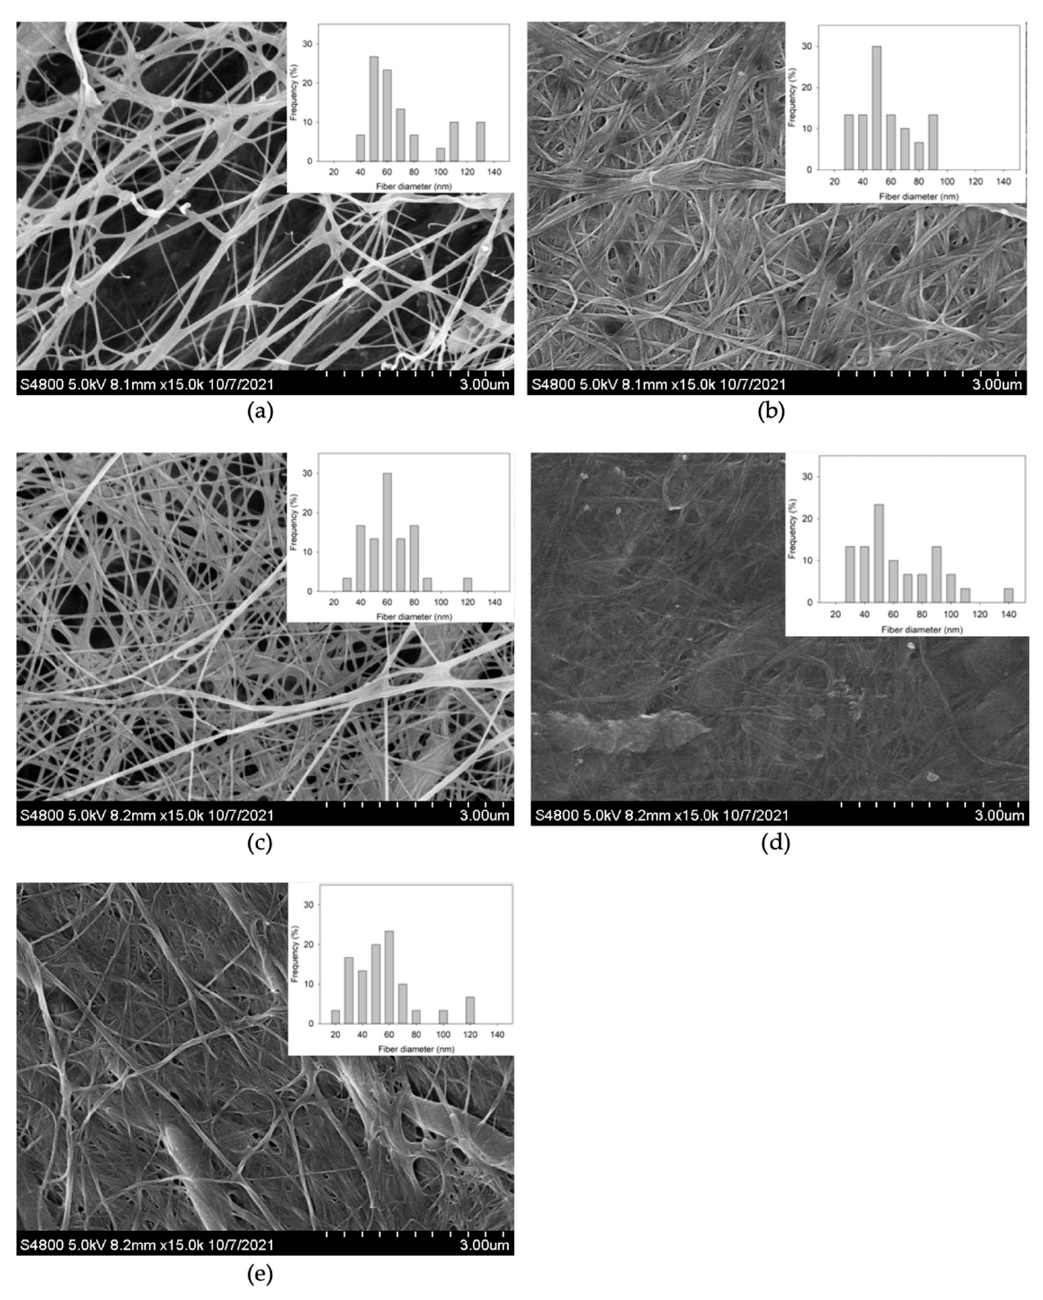
Figure 3. Visualization of BC control ( a ), 40 µg/mL ( b ), 80 µg/mL ( c ), 160 µg/mL ( d ), and 320 µg/mL ( e ) groups, and its fiber size distribution ( n = 30).